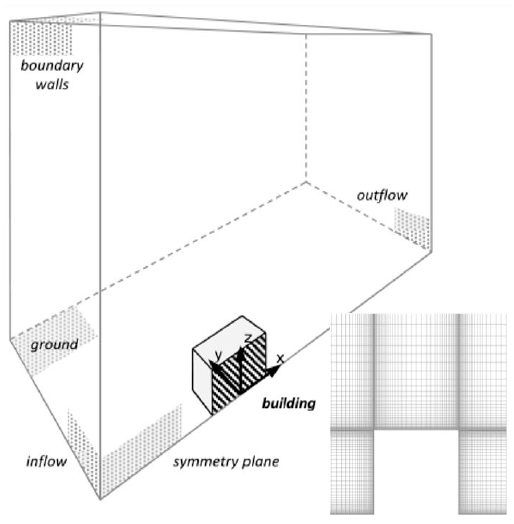
Figure 2. Mesh and boundary conditions applied to the CFD model.